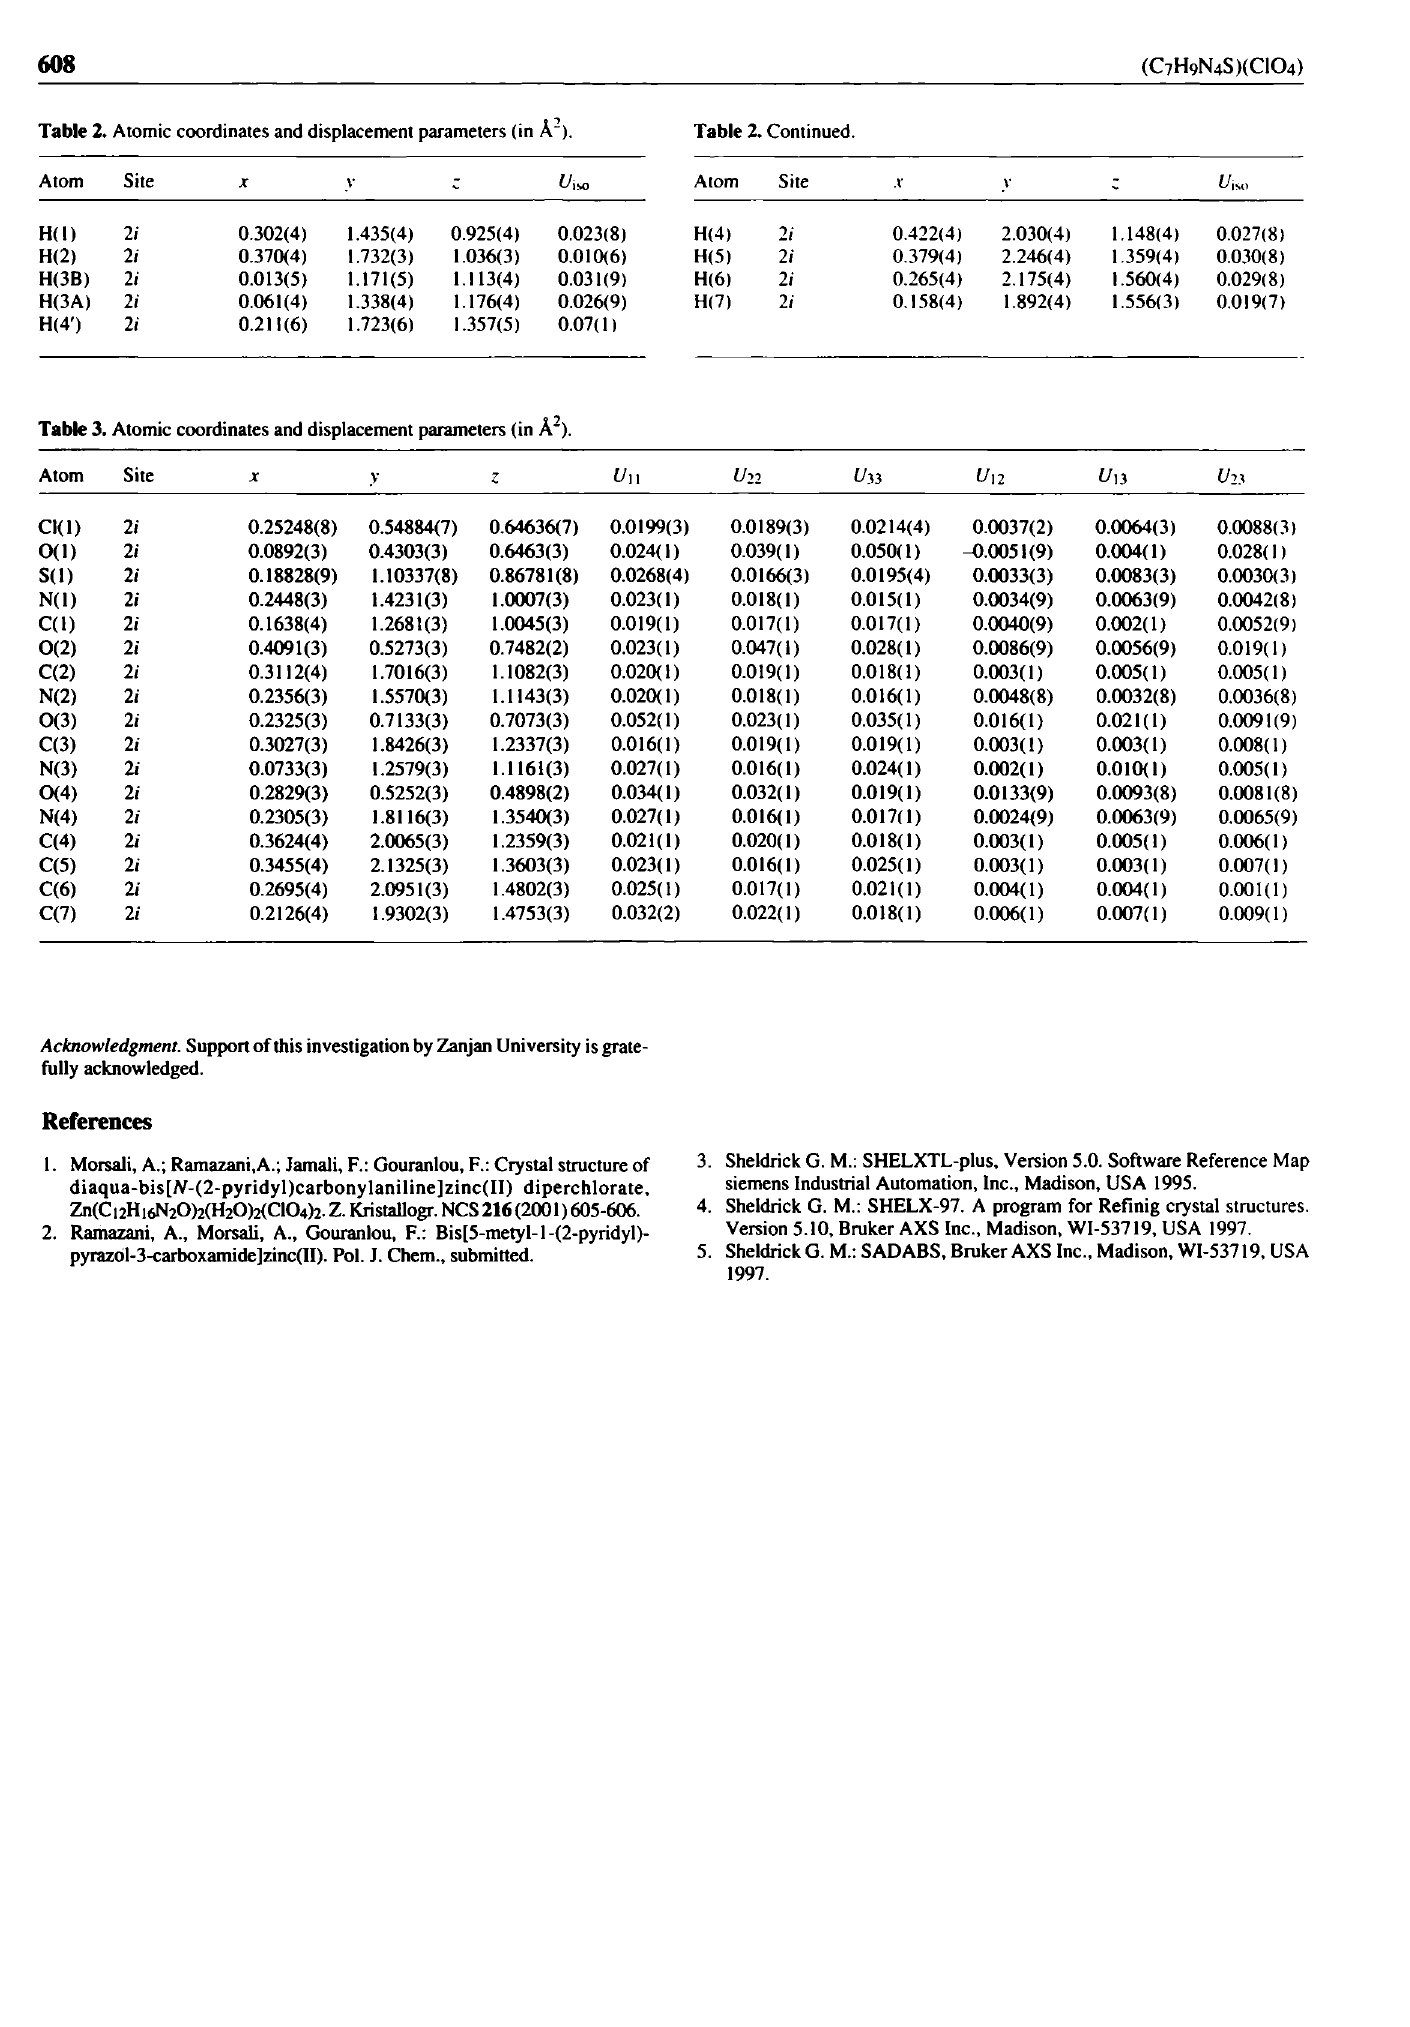
Table 3. Atomic coordinates and displacement parameters (in A 2